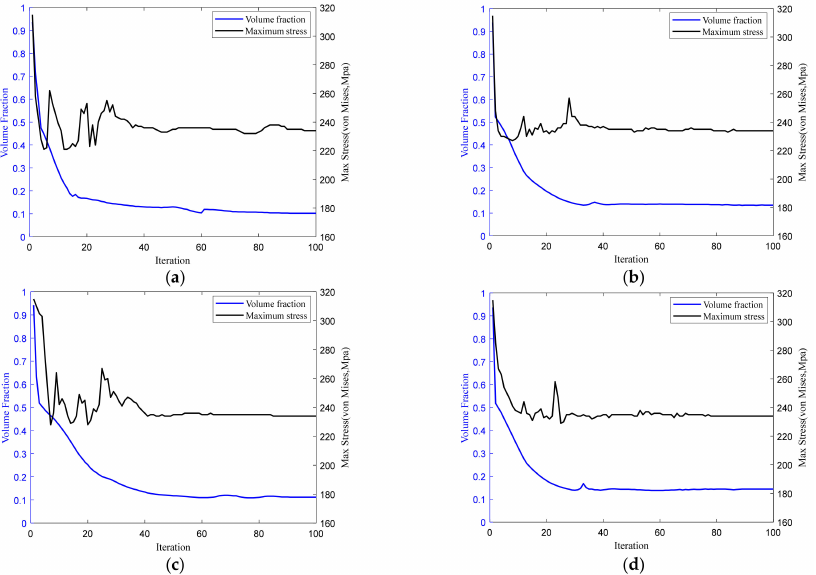
Figure 16. Volume fraction and maximum von Mises stress iteration curves of ( a ) DTO ( ∆ T = 20 ◦ C) and ( b ) RBTO ( ∆ T = 20 ◦ C); ( c ) DTO ( ∆ T = 30 ◦ C) and ( d ) RBTO ( ∆ T = 30 ◦